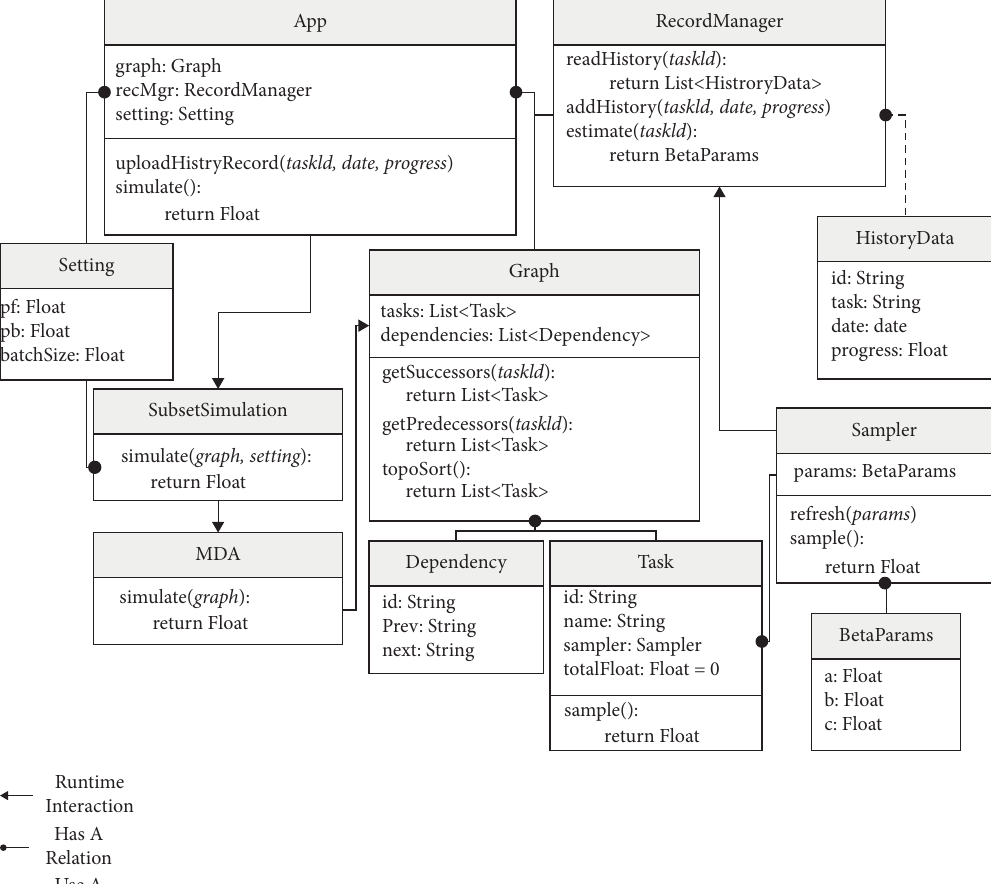
App RecordManager